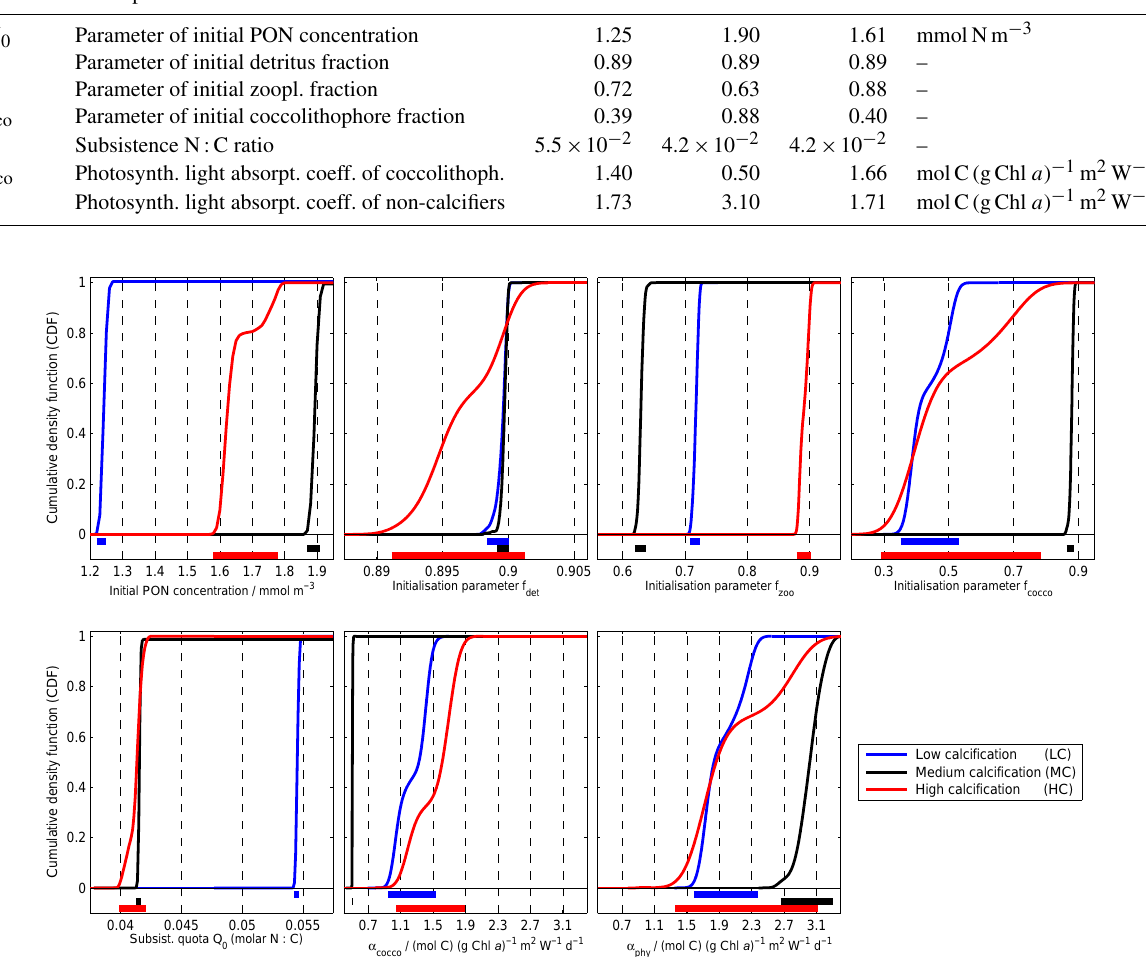
Figure 4. Probability distributions of the initial condition and physiological model parameters: the cumulative sum of non-parametric prob- ability densities (CDF) were derived from the posteriors of the Markov Chain Monte Carlo (MCMC) approach. The bars on the bottom of each panel show respective 95% credible (uncertainty) ranges of the parameter